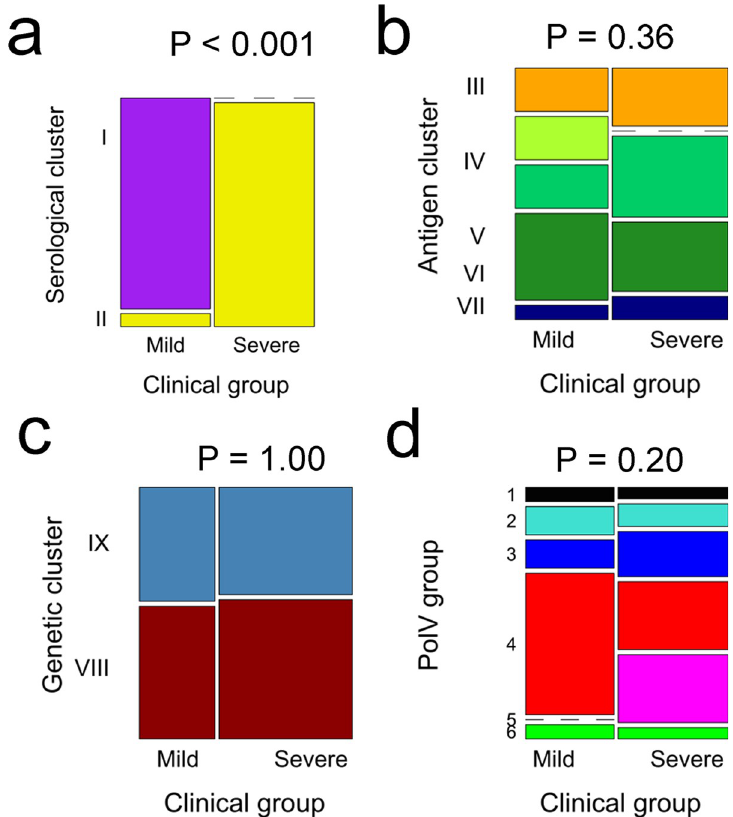
Fig 3. Associations between disease severity and clusters. Frequency distributions of clinical group (x-axis, disease severity) by a , serological cluster; b , antigen cluster; c , genetic cluster; d , PoLV group. Significance (P-values) for chi- squared tests of associations between clinical group and clusters are shown at the top of each